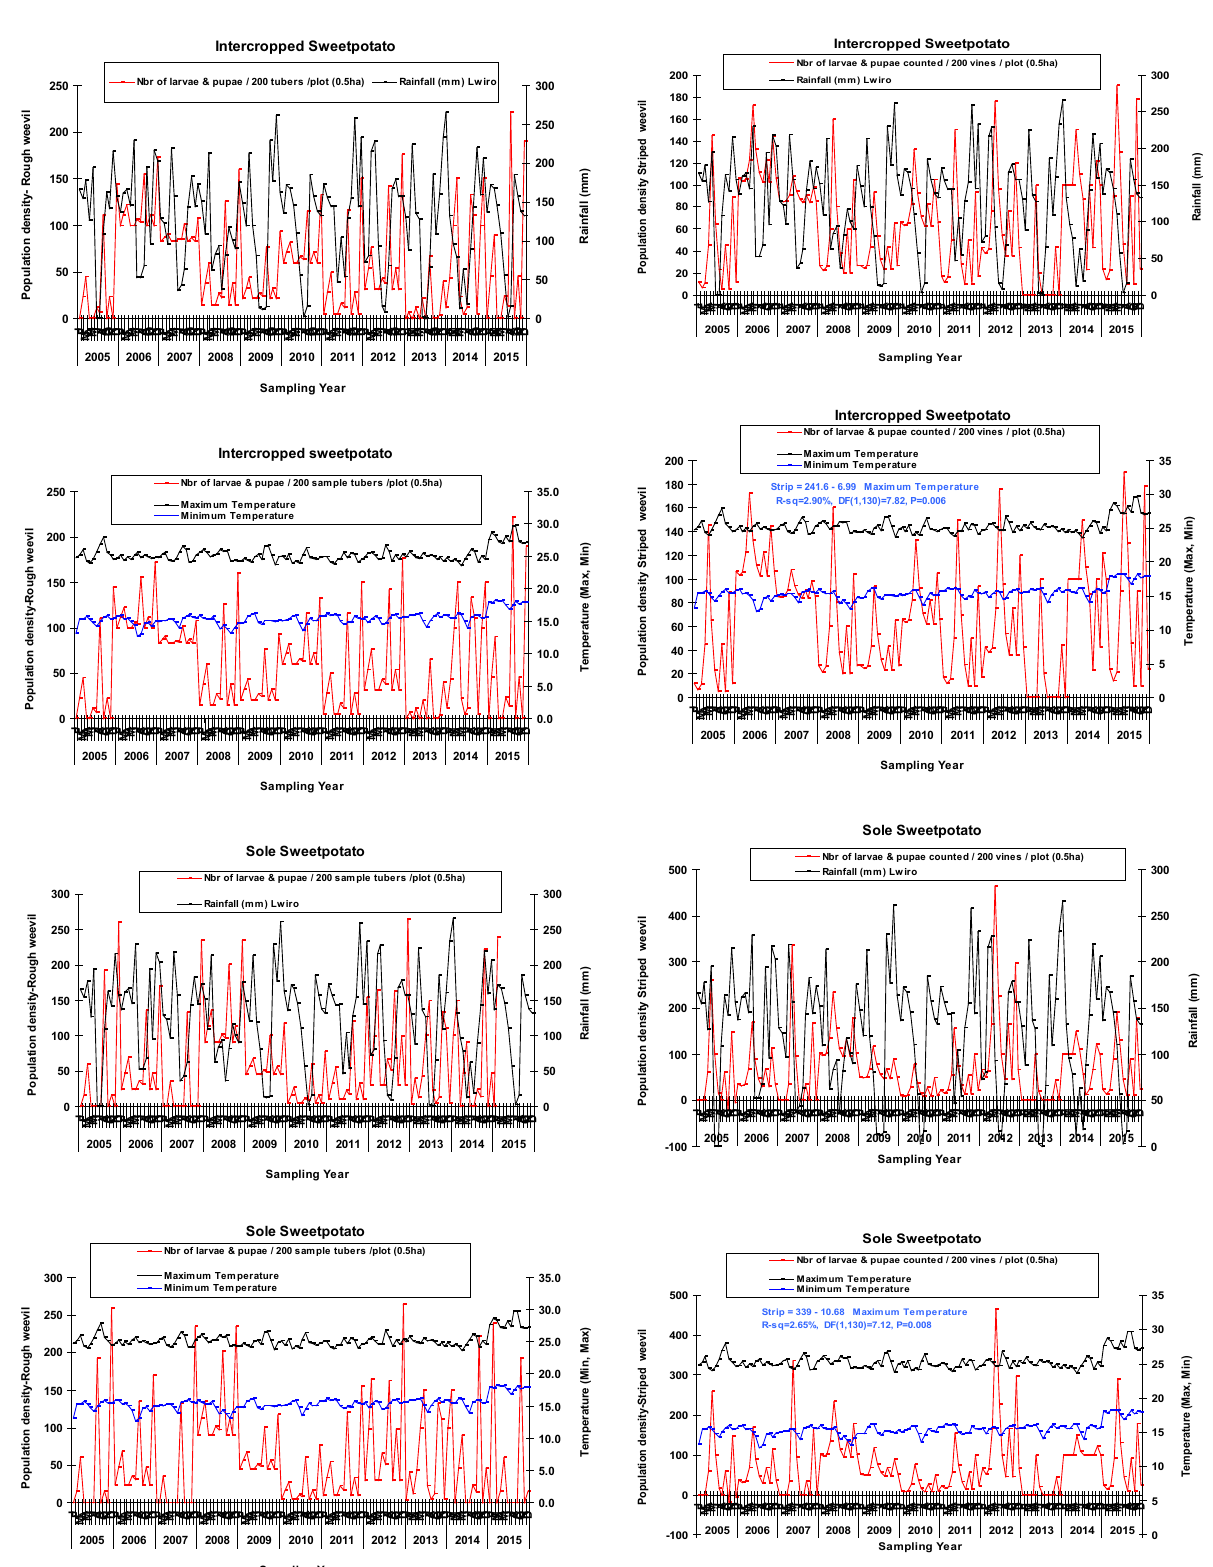
Figure 11: Fluctuation of the population density of striped weevil pest in relationship with variability in climatic factors (rainfall, tem- perature) under intercropping and mono-cropping systems in